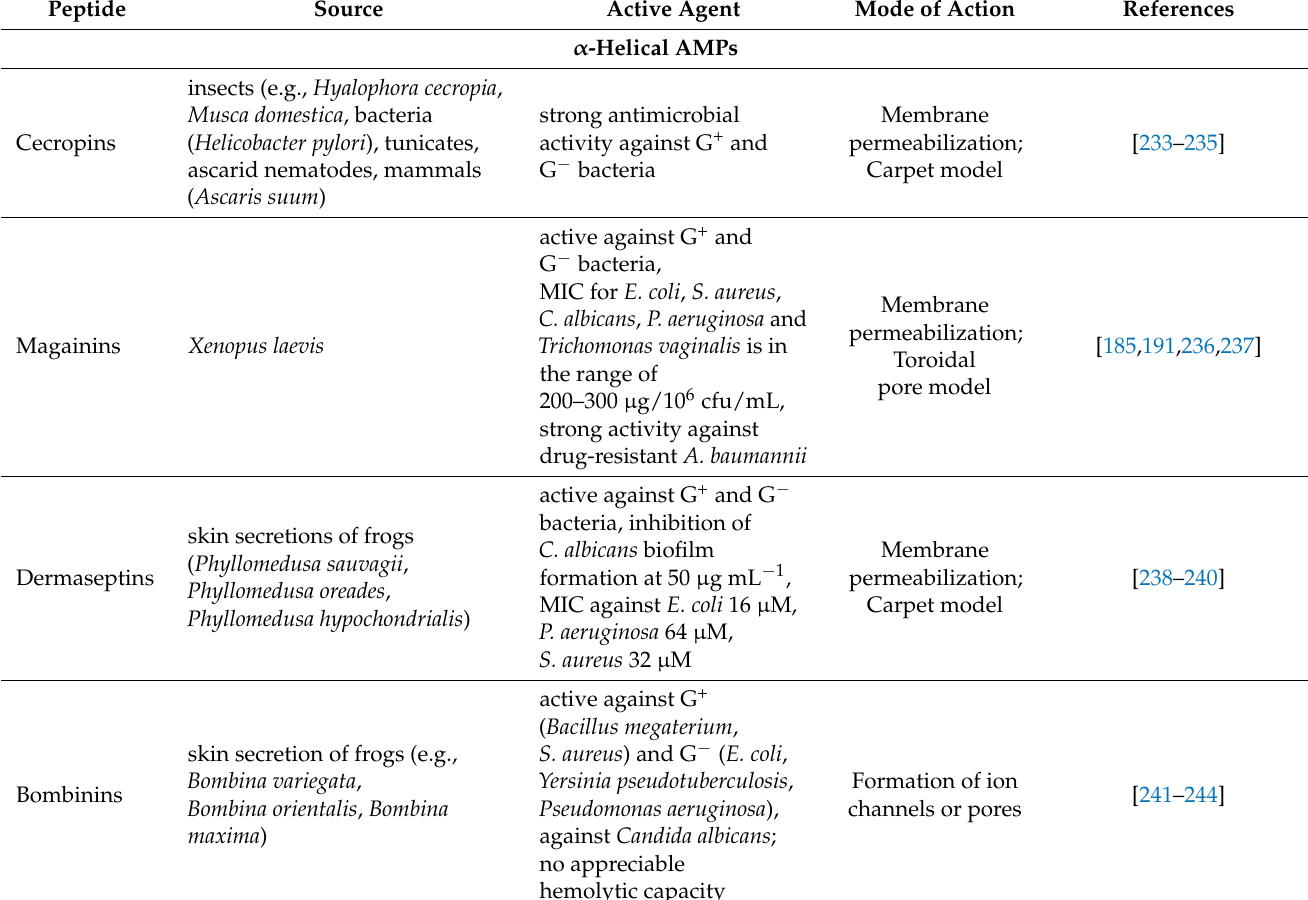
Table 3. Summary of antibacterial peptides, known and described in the available literature. Active